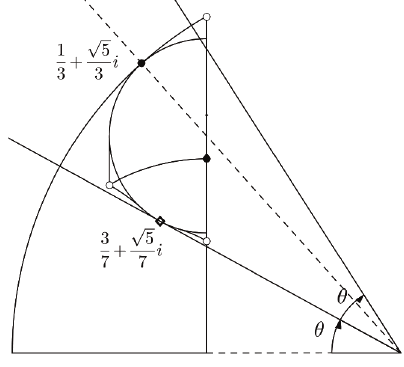
Figure 15. Proving the lower bound on the angles in region